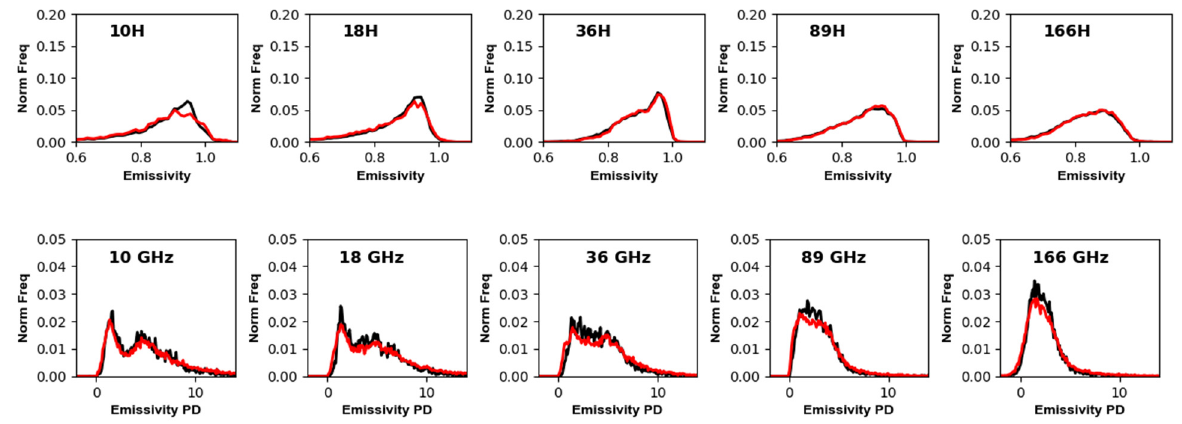
Figure 14. ( top row ). Normalized histograms of the cloud-free emissivity for the GMI 10H, 18H, 36H, 89H and 166H GHz channels, over snow and ice-covered surfaces. The black curve indicates cloud screening using only CloudSat; the red curve using only DPR. ( Bottom row ) Same as top row but showing the emissivity polarization difference (PD) defined in the main text.